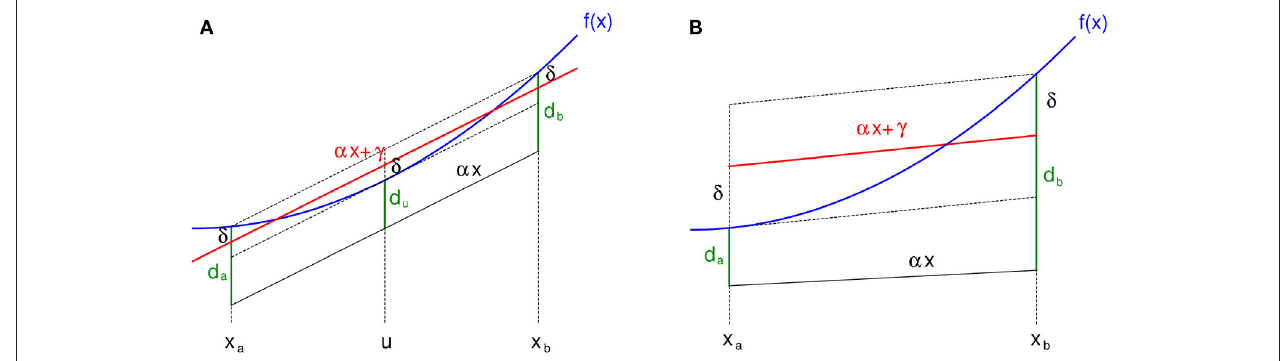
FIGURE A1 | Illustration of the two function approximations used in Arpra. (A) Chebyshev approximation and (B) Min-Range approximation. Note how by construction, the maximal errors δ are incurred at the end points x a and x b of the range in both approximations.